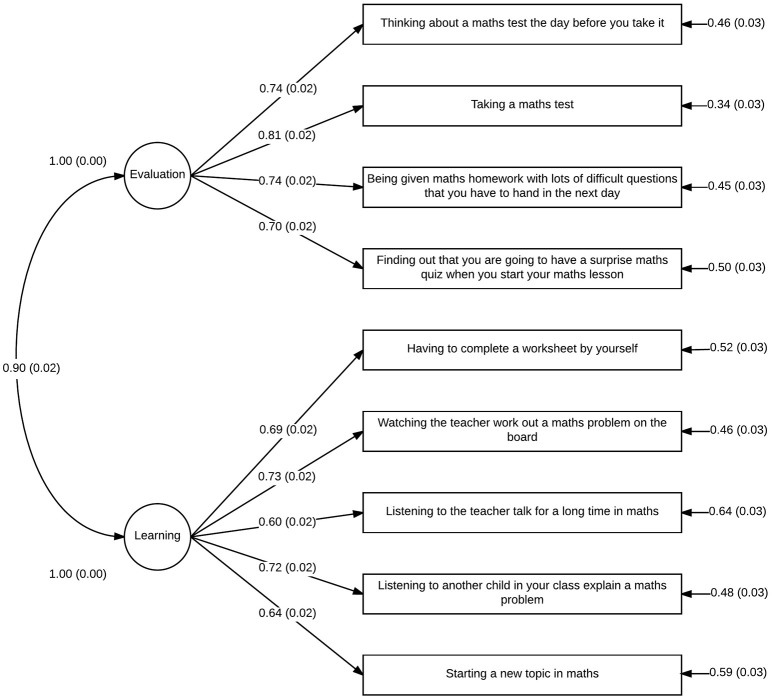
Confirmatory factor analysis of mAMAS: path diagram for year 4 students.